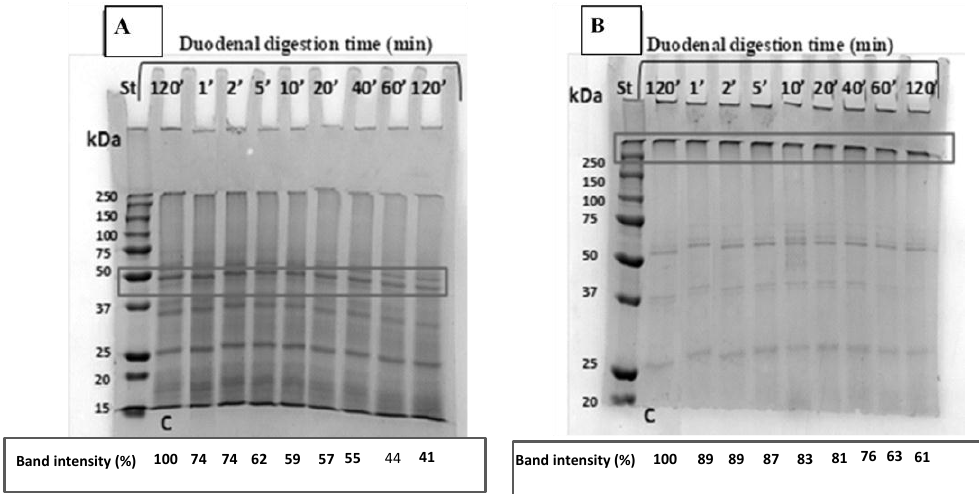
Figure 5. ( A ) Duodenal in vitro digestion and densitometry analysis of 50 kDa protein bands of grass pea film cast without mTGase; ( B ) Duodenal in vitro digestion and densitometry analysis of protein bands of >250 kDa) of grass pea film cast in the presence of mTGase (33 U/g). SDS-PAGE 12%. Molecular weight standard, Bio-Rad. C is control sample incubated without chymotrypsin and trypsin. St, Molecular weight standards, Bio-Rad.